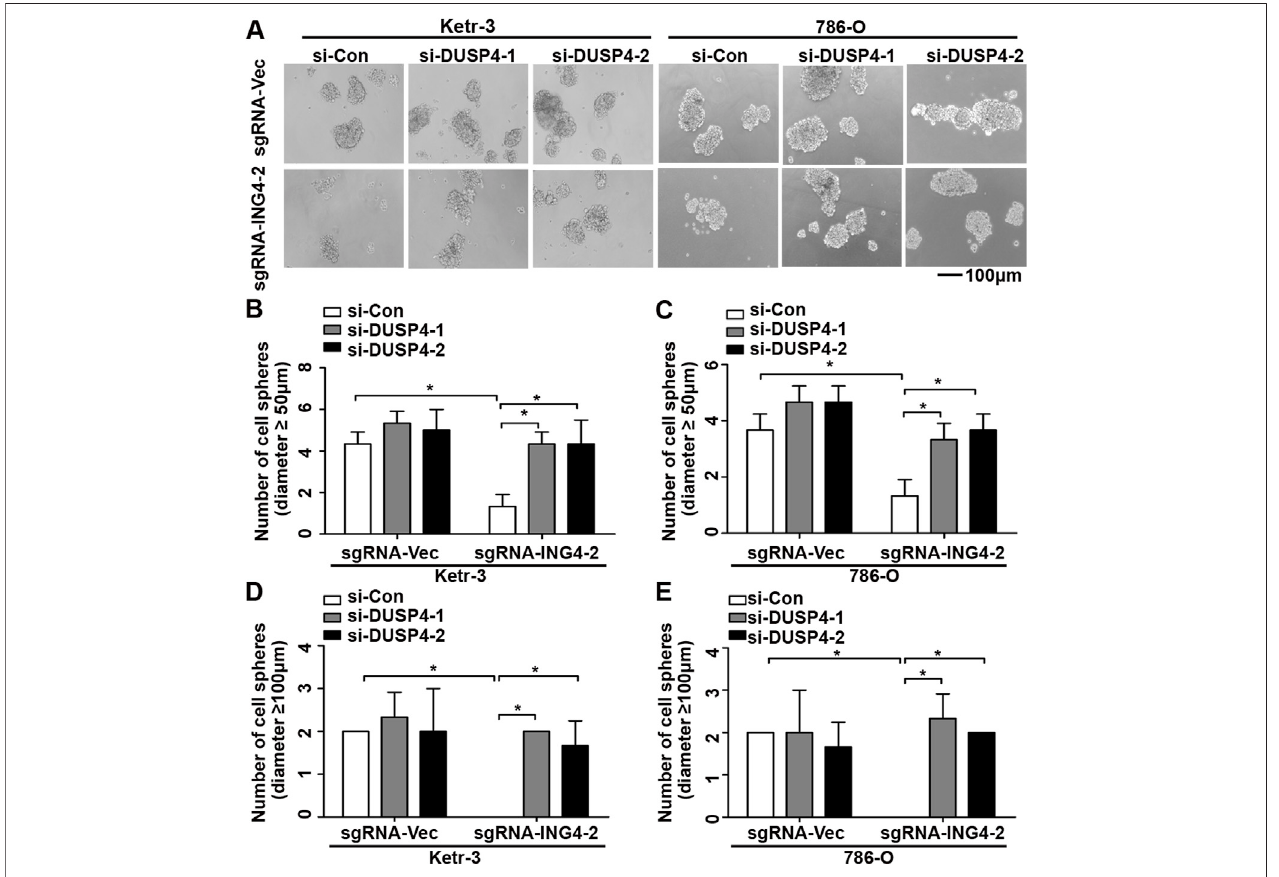
FIGURE 7 | Inhibition of DUSP4 expression signi fi cantly reversed the reduction of cell sphere formation after ING4 knockdown. (A) Photographs of cell spheres in ING4 knockdown (sgRNA-ING4-2) or vector control (sgRNA-Vec) Ketr-3 and 786-O cells after transfection with DUSP4 (si-DUSP4) or control siRNA (si-Con) (n = 3). (B – E) Thenumber ofcell spheres with diameters ≥ 50 μ m or ≥ 100 μ m.Imagemagni fi cation, ×100;scale bar,100 μ m; dataarepresentedasmean ±standard deviation. *p <